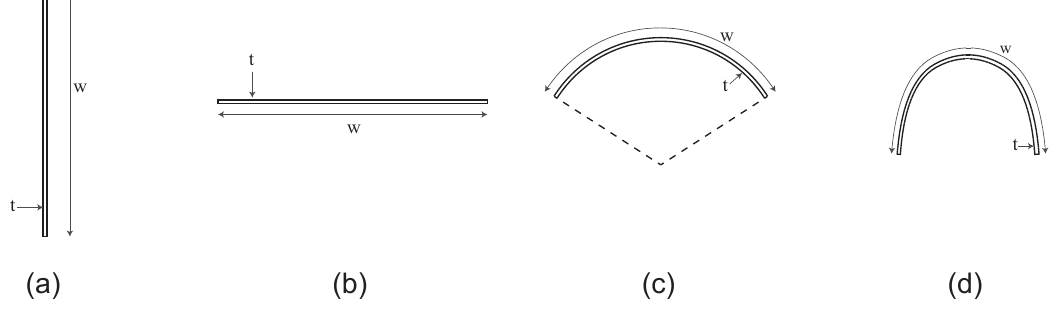
Figure 2. The four cross-sectional shapes that are considered are (a) a flat vertical in-plane strip, (b) a flat horizontal out-of-plane strip, (c) an arc and (d) a curved U-section. All shapes have the same thickness t = 1mm and length w = 10mm.